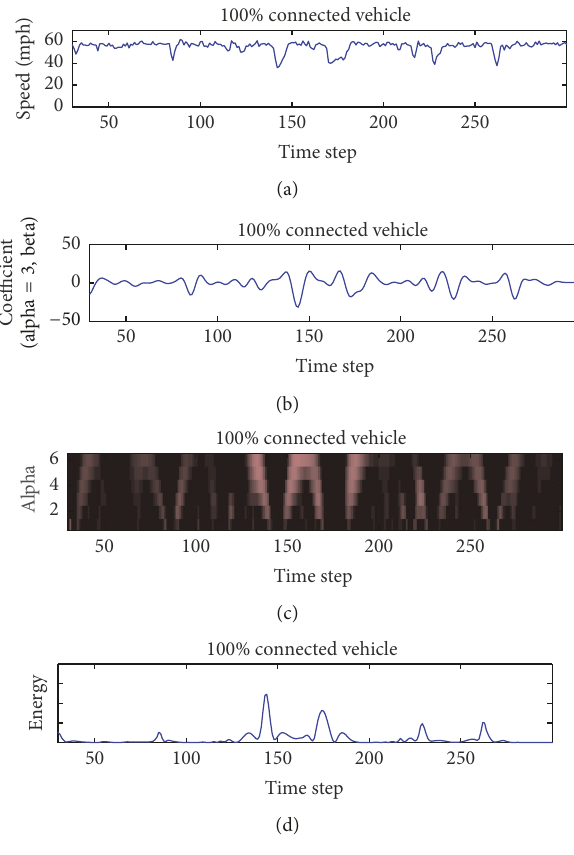
Figure 1: A sample of CWT